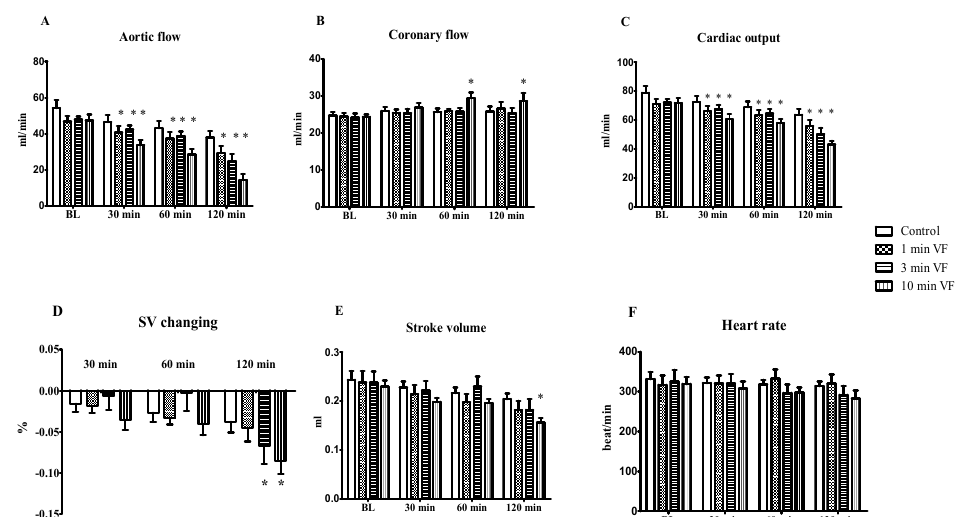
Figure 1. Effects of electrically induced ventricular fibrillation (VF) and post-fibrillation recovery on cardiac function in isolated working heart preparation. Isolated working hearts taken from ketamine/xylazine-anesthetized Sprague-Dawley rats and segregated into test groups of 6 hearts per group were subjected to 0 (Control), 1, 3, and 10 min periods of electrically-induced VF (20 Hz, 1200 beats/min), respectively. Each heart was then perfused with oxygenated Krebs-Henseleit bicarbonate buffer, and then allowed post-fibrillation recovery periods for 30, 60, and 120 min. Cardiac function was registered following each electrical VF induction and recovery period, including aortic flow ( A ); coronary flow ( B ); cardiac output ( C ); stroke volume changing ( D ); stroke volume ( E ); and heart rate ( F ). Results are shown as average values from each group of rat hearts ± SEM. n = 6 in each group, * p < 0.05 in comparison with the time-matched control values.